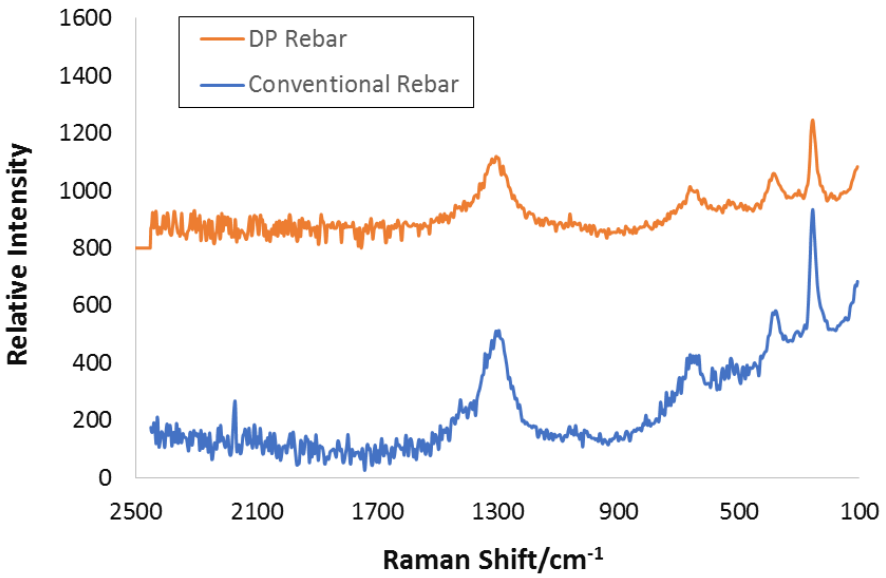
Figure 11. Raman spectroscopy images in an alkaline solution after potentiodynamic polarization. Appl. Sci. 2020 , 10 , x